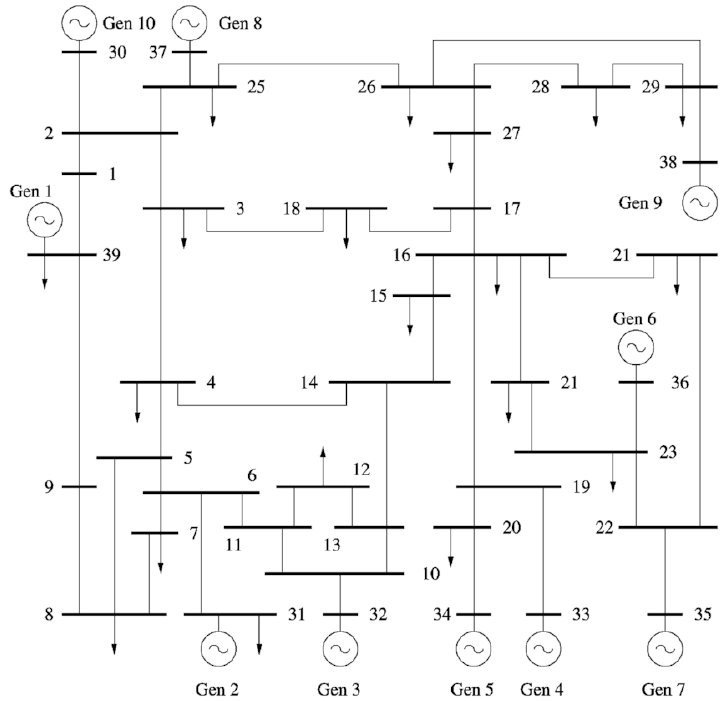
Figure 4. 10 machine-39 bus